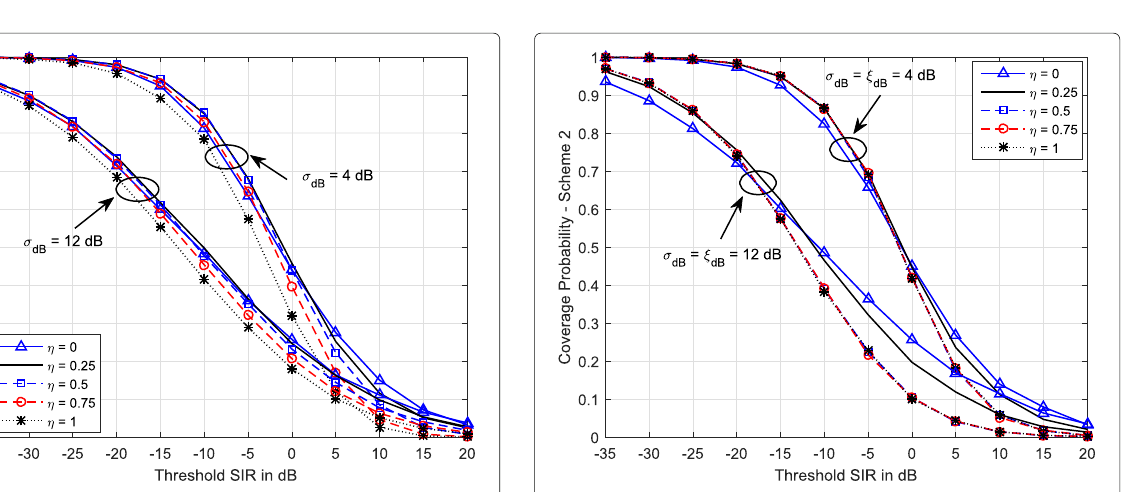
Fig. 5 Coverage probability of Scheme 2 vs SIR threshold for different η values. λ = 0.5 BSs/km 2 , α = 3.5, ρ = − 30